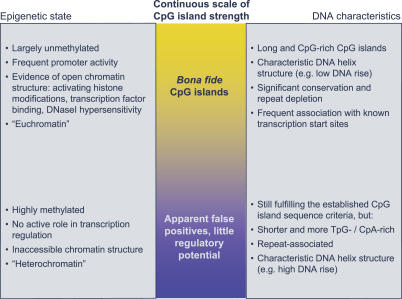
Parallelism between Specific DNA Characteristics and the Epigenetic and Functional State of CpG IslandsThis figure illustrates the link between the genome sequence and the epigenome at CpG islands, which enabled us to predict epigenetic states from characteristics of the genome sequence. CpG islands in the human genome can apparently be ordered on a scale of increasingly open and transcriptionally competent chromatin structure (left) and simultaneously on a scale of characteristic DNA attributes (right), with high correlation between both scales.